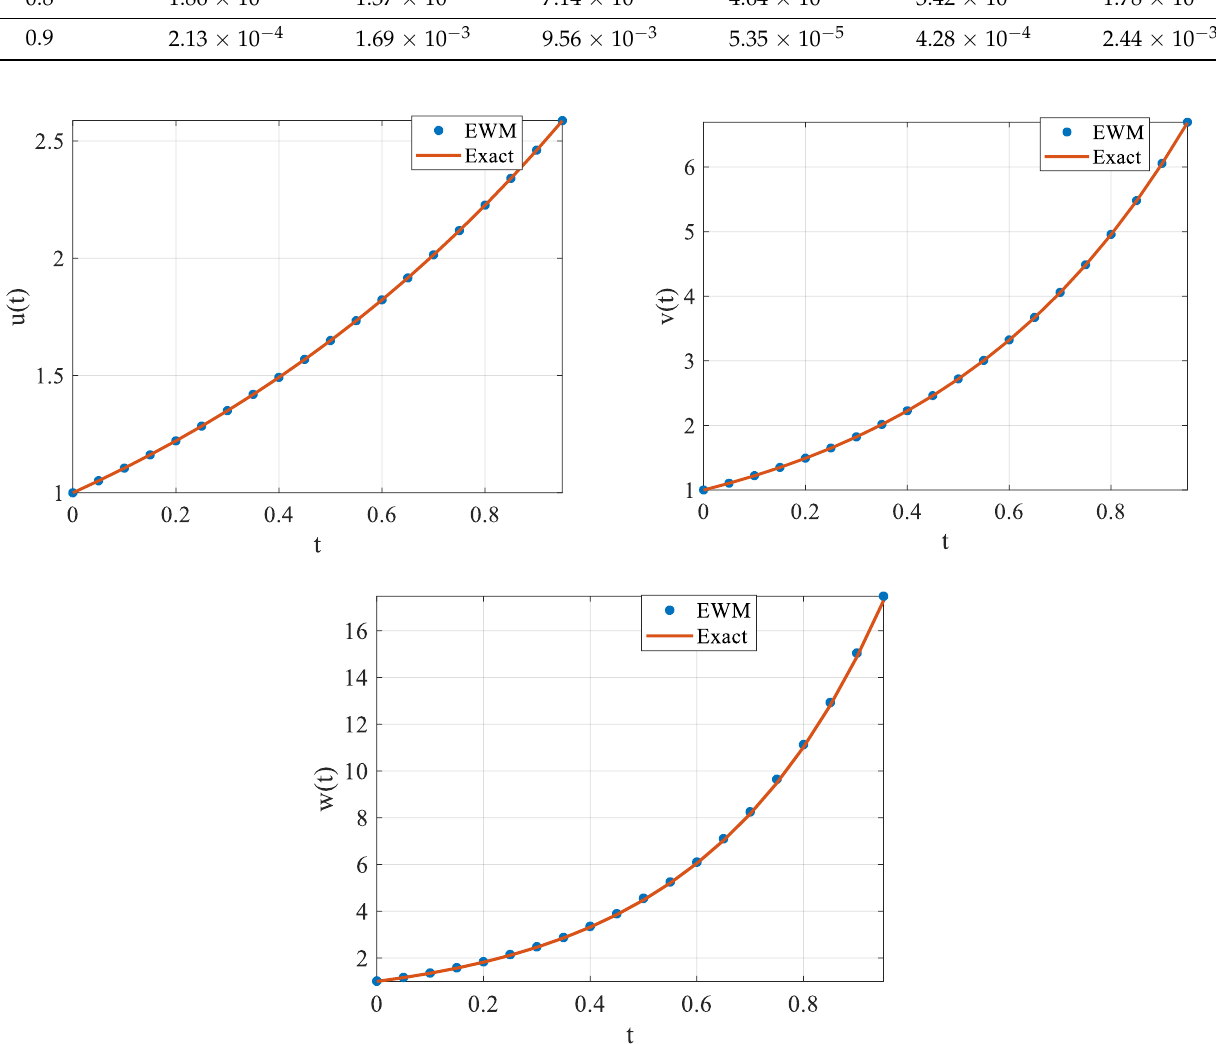
Figure 7. Numerical and exact solutions for u ( t ) , v ( t ) and w ( t ) for α = 1, β = 1, and γ = 1 for Example 4 ( m (cid:48) = ).